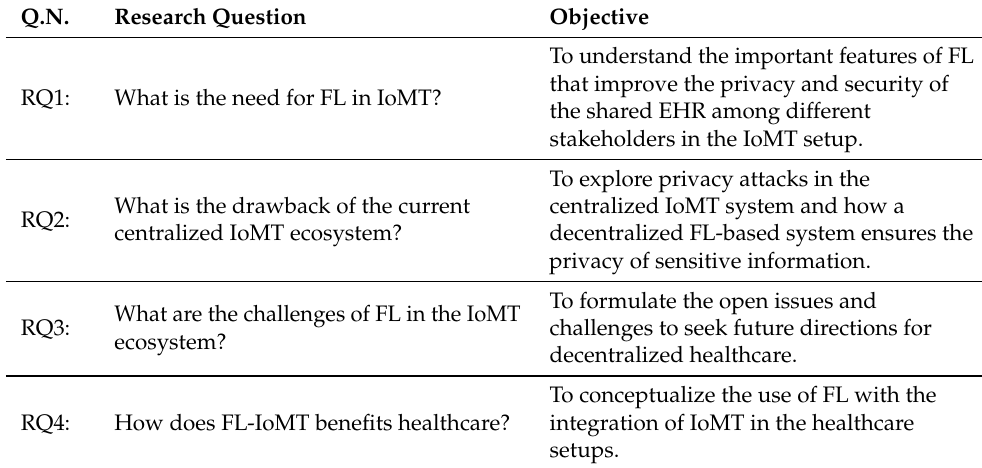
Table 4. Research question of the proposed